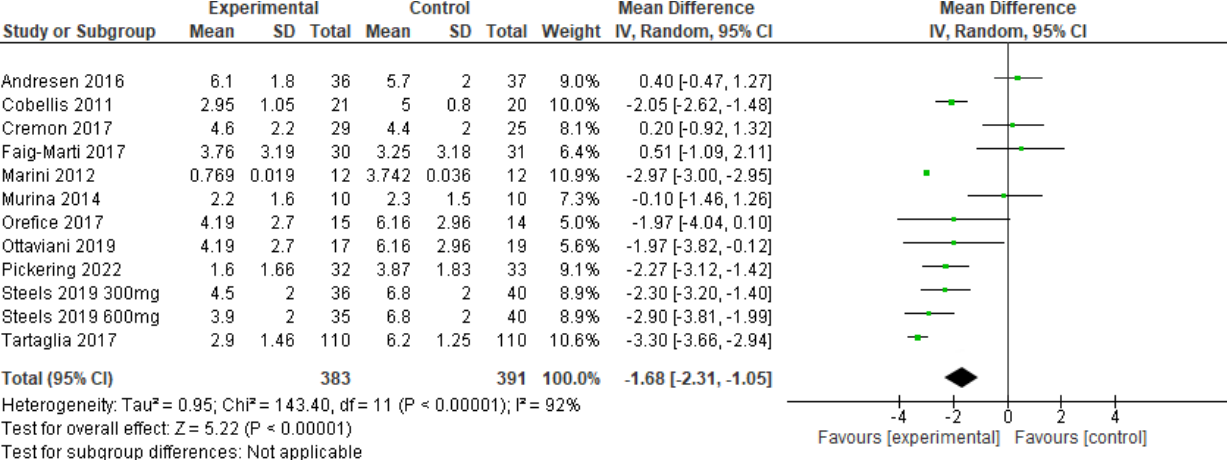
Figure 4. Forest plot of the effect of palmitoylethanolamide (PEA) on chronic pain intensity [25–35]. Experimental refers to PEA, while control refers to placebo or active treatment comparator. Lines represent 95% confidence intervals for each study’s effect size, and the black diamond represents a pooled estimate using a random effects statistical model.